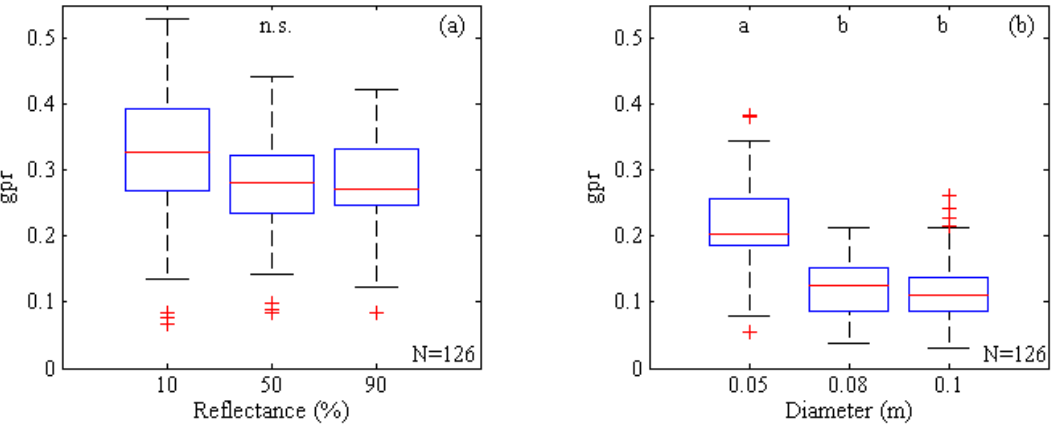
Figure 6. Boxplots of ghost points ratio gpr . ( a ) Three reflectances; and ( b ) three diameters in the leaves ( N = 126) and the branches ( N = 126) setup, respectively. The box represents the interquartile range of the data (the 25th and 75th percentiles), and the whiskers represent the inner 10th and 90th percentiles. Box plots with different letters indicate significant differences between them (Tukey test, p < 0.05), and n.s. indicates differences that are not significant ( p > 0.05). Outliers are represented by plus (+)